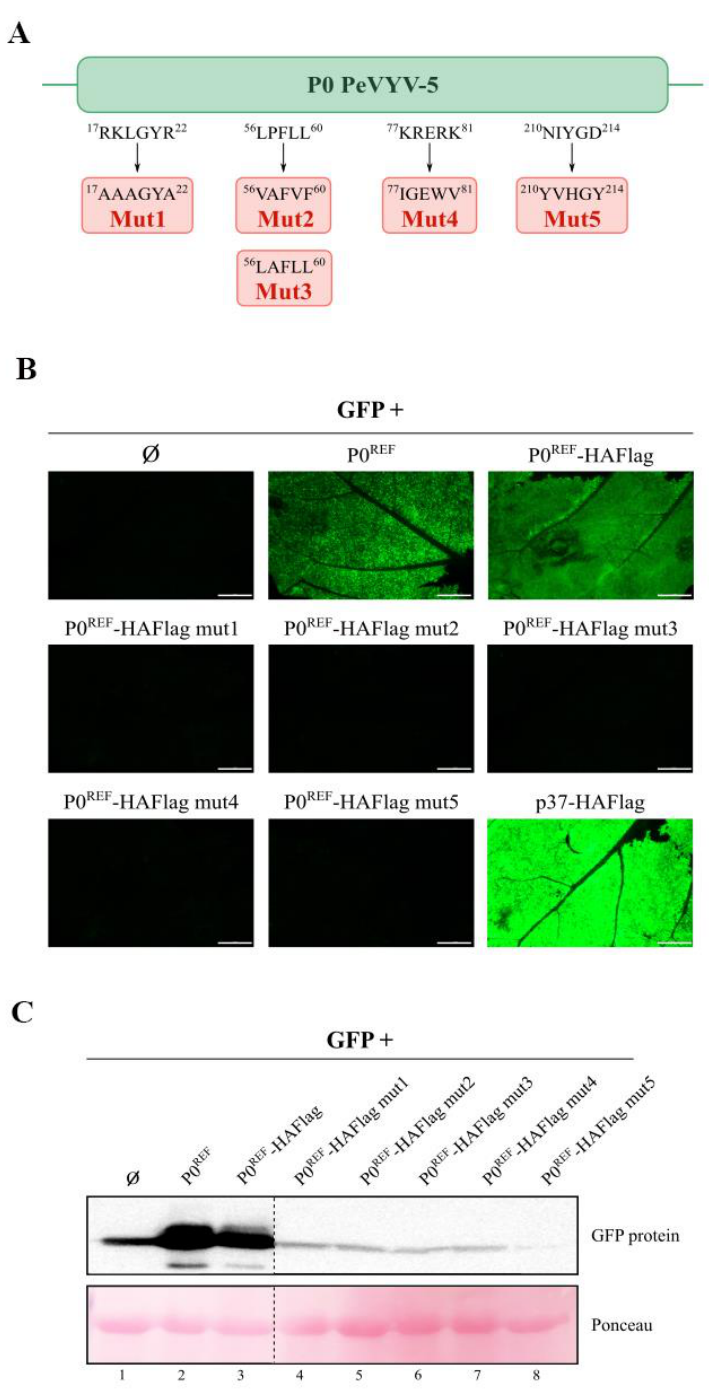
Figure 6. Analysis of RNA silencing suppressor activity of engineered variants of PeVYV-5 P0 REF . Distinct nucleotide substitutions were engineered through site-directed mutagenesis into (HAFlag- tagged) P0 REF gene giving rise to amino acid replacements in the derived proteins. The mutated constructs (mut1–5) were co-infiltrated with the GFP construct in N. benthamiana leaves. The GFP construct was also agroinfiltrated alone (Ø) or in combination with the construct directing expression of HAFlag-tagged P0 REF , to be used as control samples. ( A ) Schematic representation of the P0 REF protein with the amino acid replacements present in each engineered variant. ( B ) GFP fluorescence at 10 dpif in infiltrated leaf patches. The inset scale bar corresponds to 5 mm in all panels. ( C ) Western blot analysis for detection of GFP. Ponceau S staining is shown below Western results as loading control.